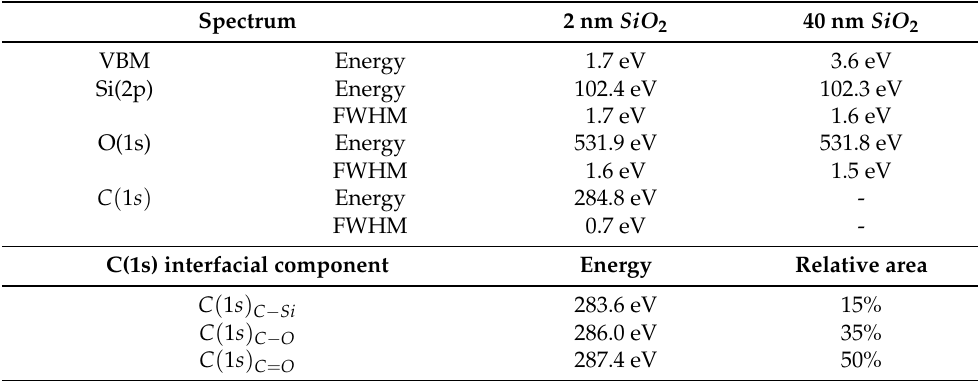
Figure 3. ( a ) XPS spectra of the VB, Si(2p), and O(1s) recorded on the 40 nm SiO 2 layer sample. ( b ) XPS spectra of the VB, Si(2p), C(1s), and O(1s) recorded on the 2 nm SiO 2 layer sample. The VB and peak heights are scaled for better comprehension of the reader in ( a , b ). The factors used to scale the VB and peak heights are displayed as well in ( a , b ) referenced to the Si(2p) height in each measurement. ( c ) XPS deconvoluted spectrum of the C(1s) peak recorded on the 2 nm SiO 2 layer sample. Table 1. Summary of the XPS peaks’ energy and full-width at half-maximum (FWHM) for the two studied samples (2 nm and 40 nm of SiO 2 ). The C(1s) deconvoluted interfacial components’ (measured on the 2 nm SiO 2 sample) energies and relative areas’ (RA) are also shown at the bottom of the table. The RA is calculated as the ratio of the area between one of the interfacial component over the sum of the areas of all of